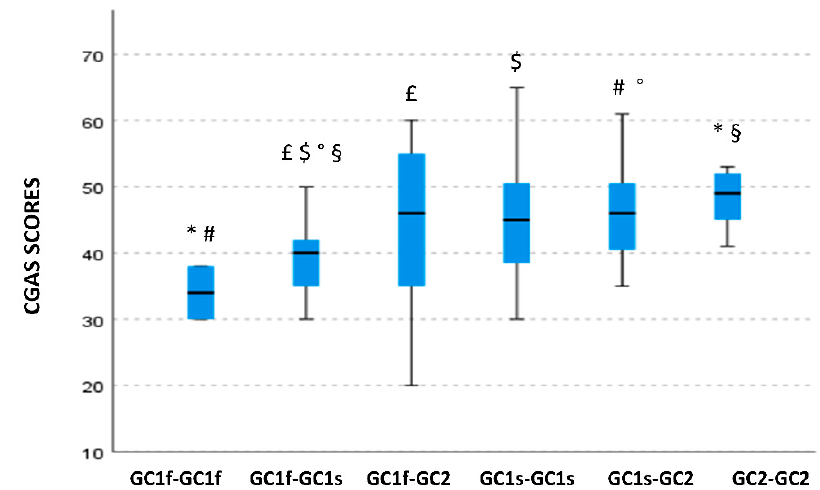
Figure 4. Boxplot of the distribution of CGAS scores in relationship with the GC isoform phenotypes. Within each box black lines denote median values. Statistically significant pairwise comparisons are reported: *: p = 0.028 #: p = 0.049 £: p = 0.048 $: p = 0.019 ◦ : p = 0.007 and §: p = 0.012.